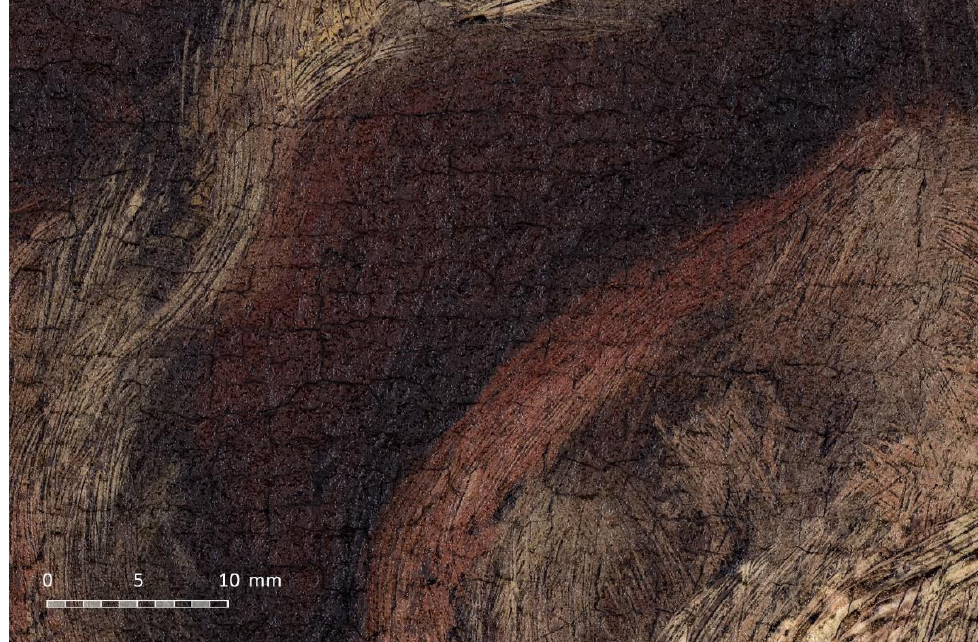
Figure 19. Fragment of the resulting gigapixel image.